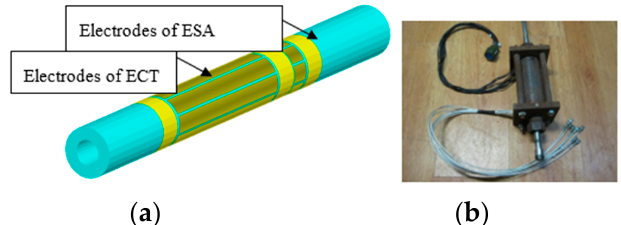
Figure 9. Integrated structures of ESA and ECT ( a ) Integrated electrodes arrangement; ( b ) photograph of the appearance.